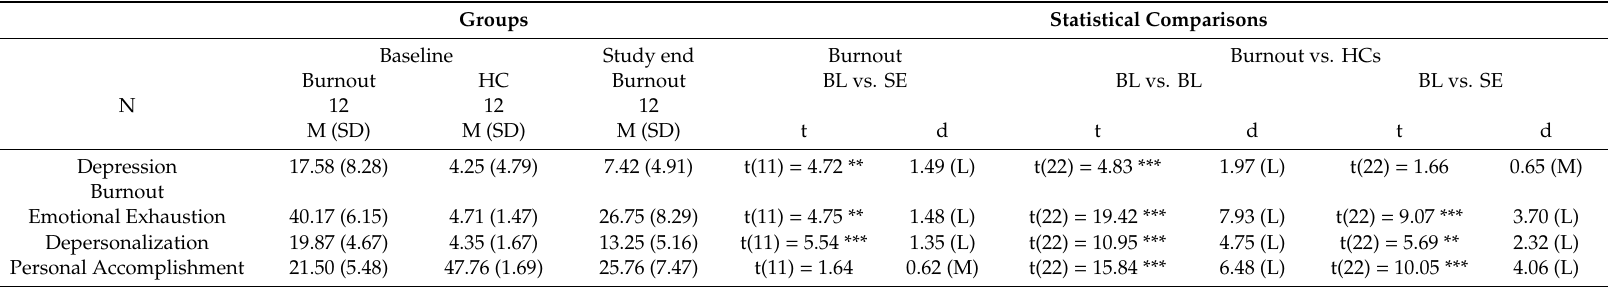
Table 1. Descriptive and statistical indices of symptoms of burnout and depression in individuals with and without burnout. Groups Statistical Comparisons